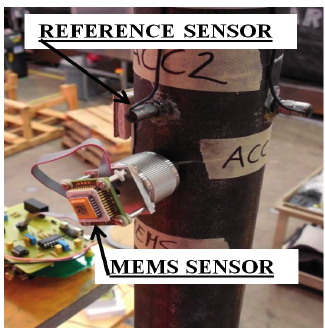
Figure 25. Setup for flow-loop pipeline test.